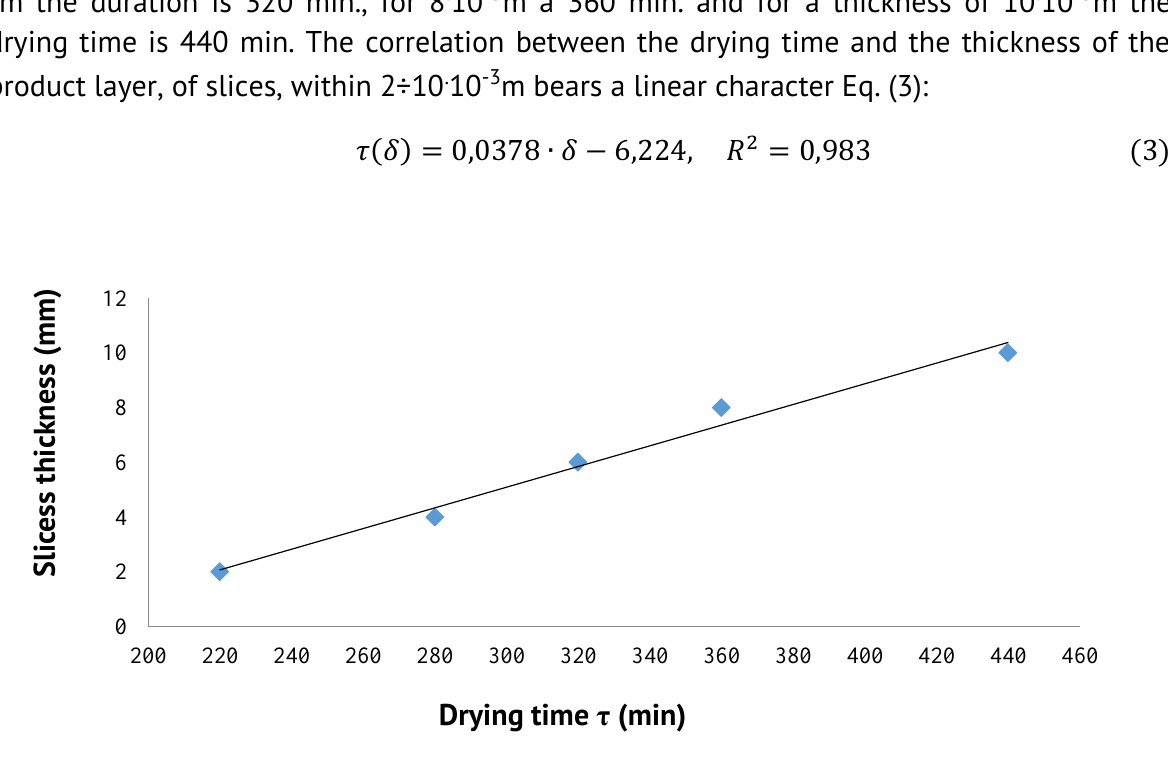
Figure 7. Correlation between SPRINGCREST peaches slices thickness and drying time (Thermal agent velocity 2.0 m . s -1 thermal agent relative humidity 60.0%, thermal agent temperature